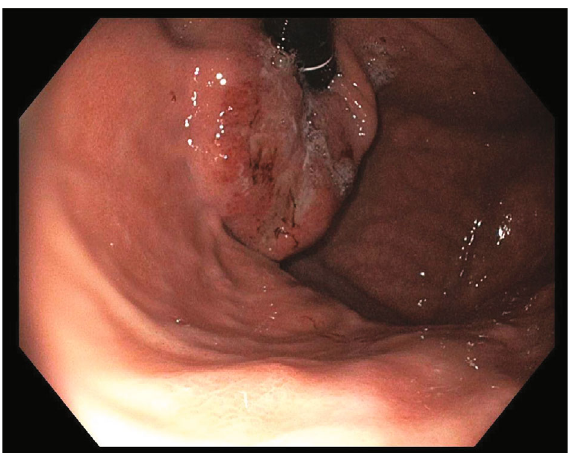
Figure 1: EGD photograph — an ulcerated mass 40 cm from incisors is shown, with stigmata of recent bleeding involving the gastric cardia, extending to the gastroesophageal junction.